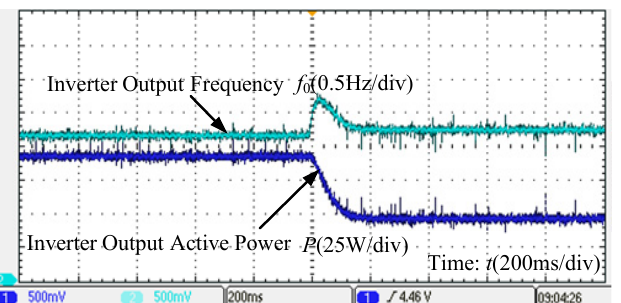
Figure 20. The output active power and frequency of the inverter when the damping coefficient D = 8.35 in a strong grid.